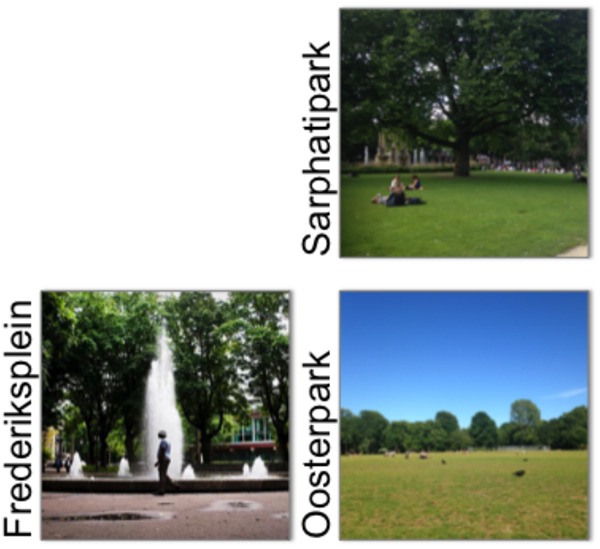
Fieldwork locations. Photo credits: Frederiksplein: Het Parool3; Sarphatipark: authors; Oosterpark: authors.